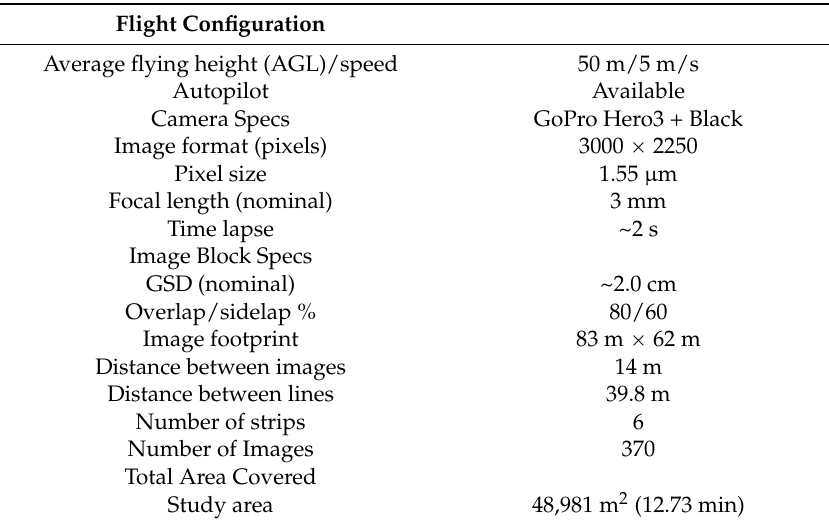
Figure 7. Graphical interface of the image capturing mission flight plan designed to cover the area of interest: ( a ) north-south flight path and ( b ) east-west flight path. Table 1. North-south flight path configuration for area of interest.